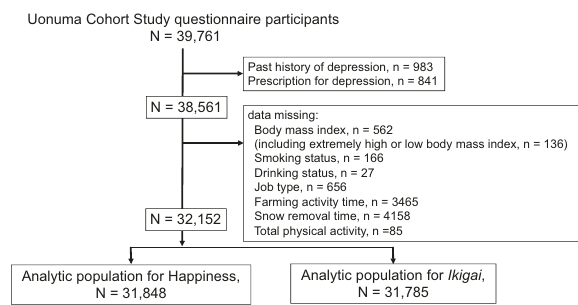
Fig. 2 Inclusion fl owchart for study